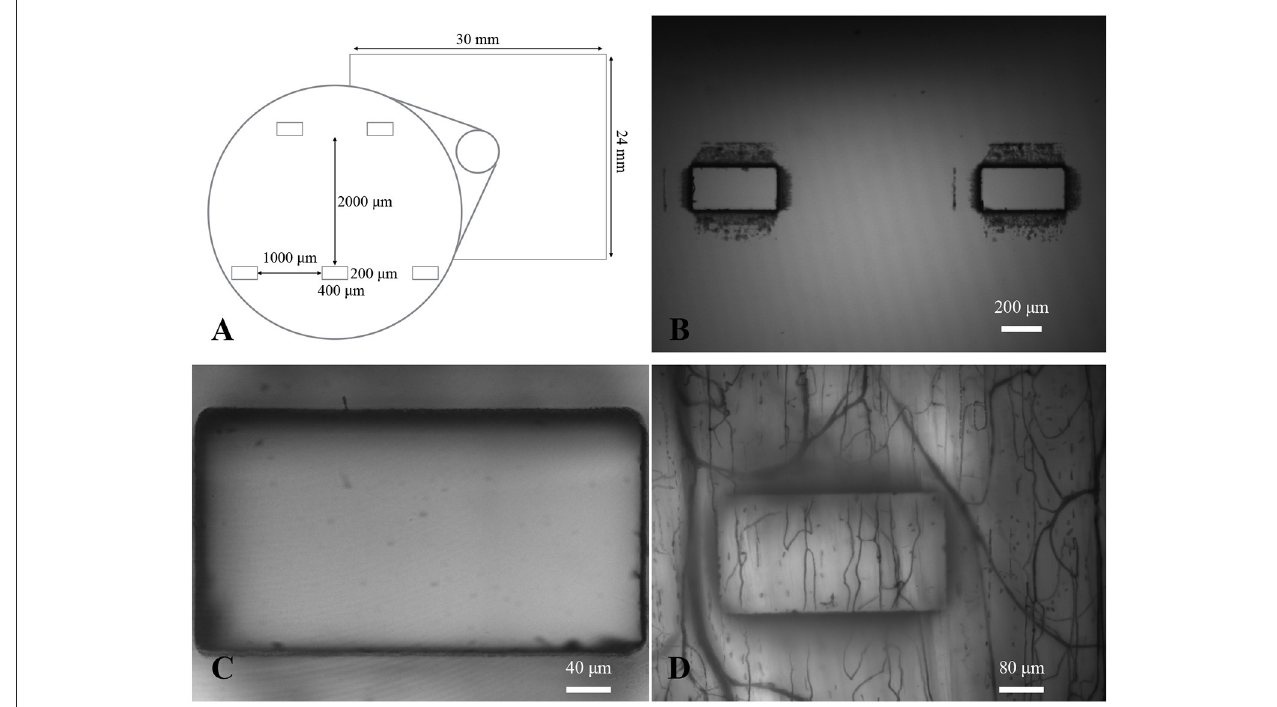
FIGURE 3 | Gas exchange window design. (A) Diagram of the design of the gas exchange windows. (B) A 4X micrograph showing two of the exchange windows centered in the field of view. Dark markings from laser machining can be seen around the edges of each window. (C) A 20X micrograph of an exchange window focused on the edge closest to the objective. (D) A 10X functional image of the minimum intensity values over time with dark lines showing location of flowing capillaries and larger micro vessels (as well as outline of the window).